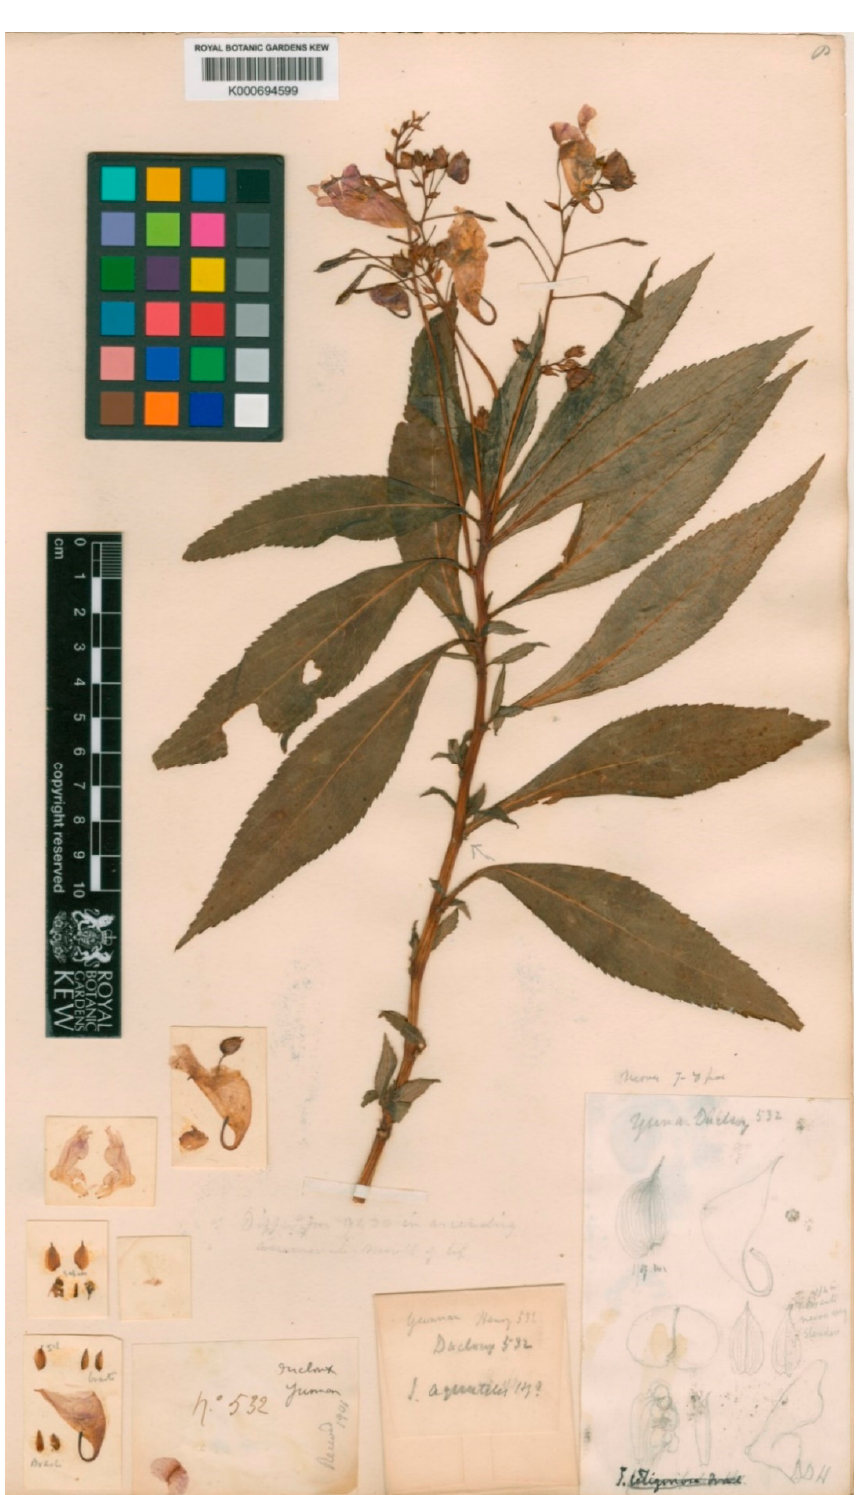
Figure 3. Lectotype of Impatiens aquatilis Hook. f. (designated here). Source from http://specimens.kew.org/herbarium/K000694599 (accessed on 6 April 2021). © copyright of the Board of Trustees of the Royal Botanic Gardens, Kew .